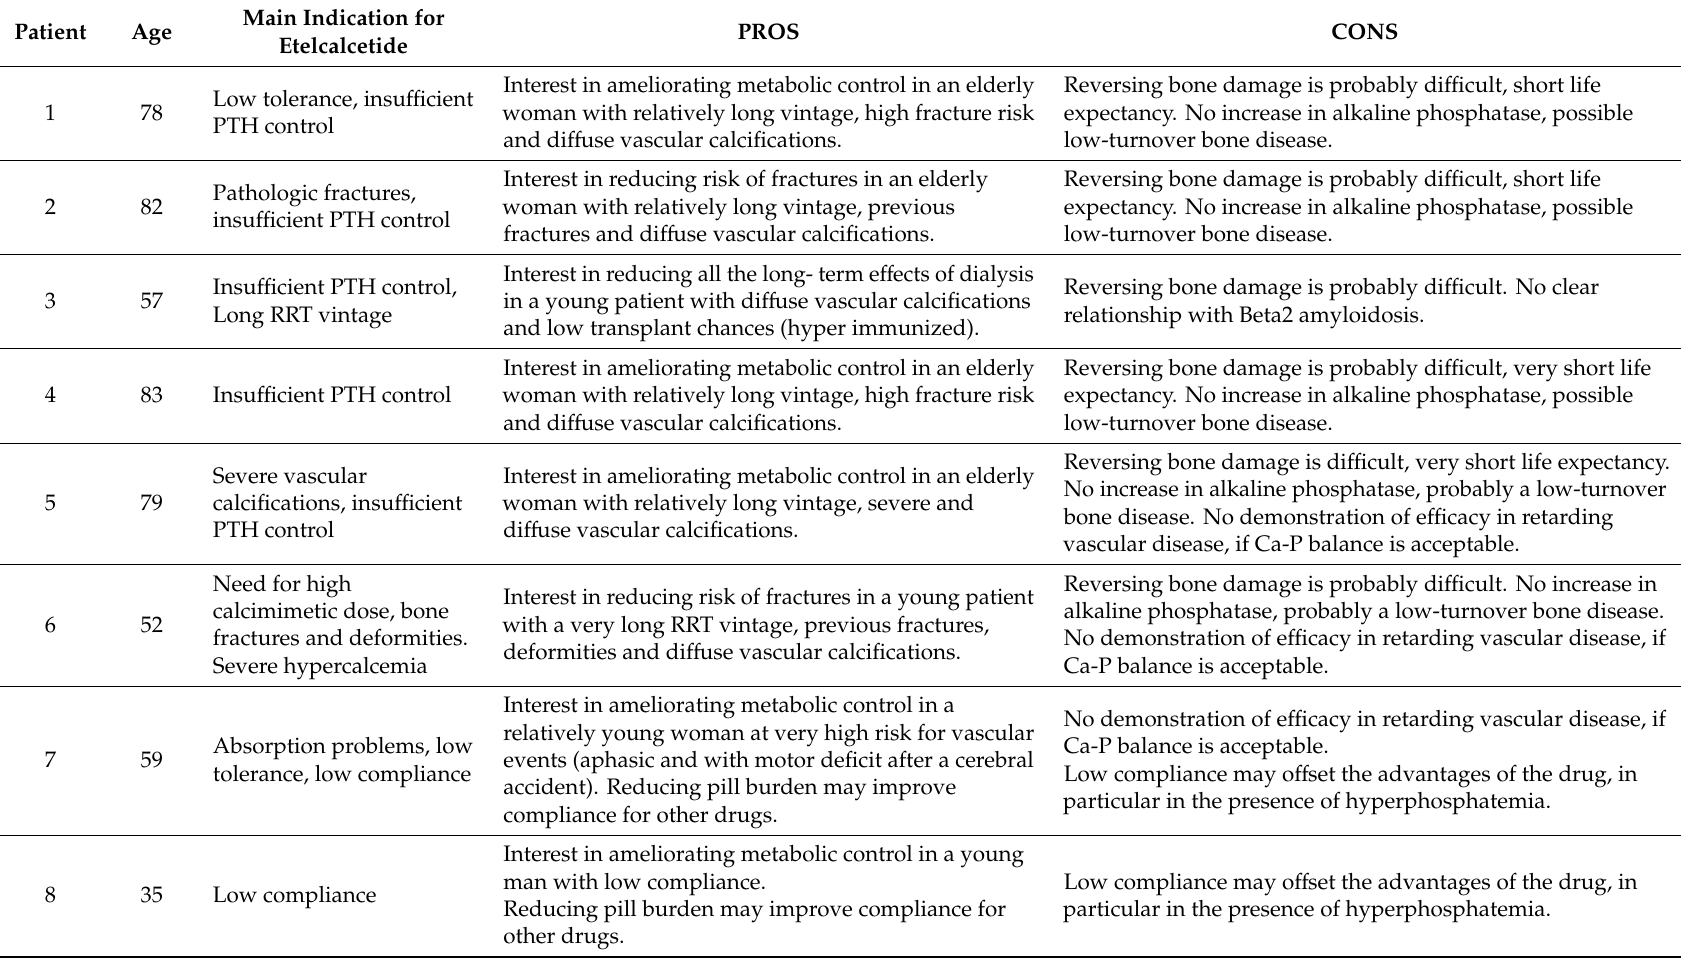
Table 2. Pros and cons of treatment: a clinical